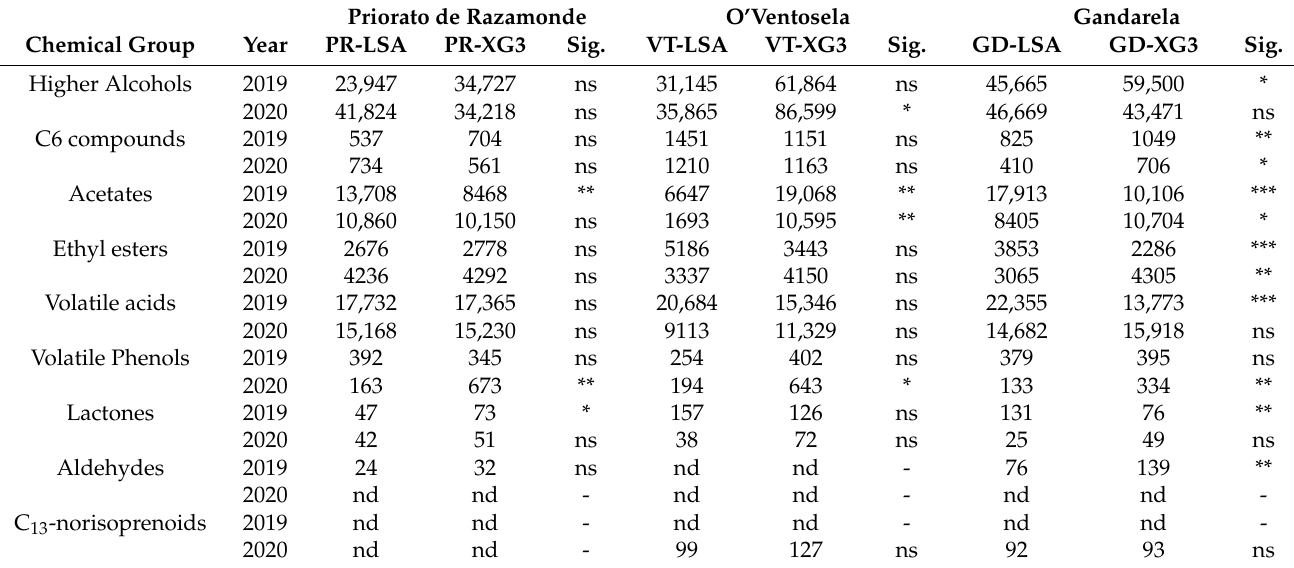
Table 4. Volatiles concentration ( µ g/L) by chemical groups identified in Treixadura wines from Priorato de Razamonde (PR), O’Ventosela (VT) and Gandarela (GD) wineries obtained with different yeasts in 2019 and 2020